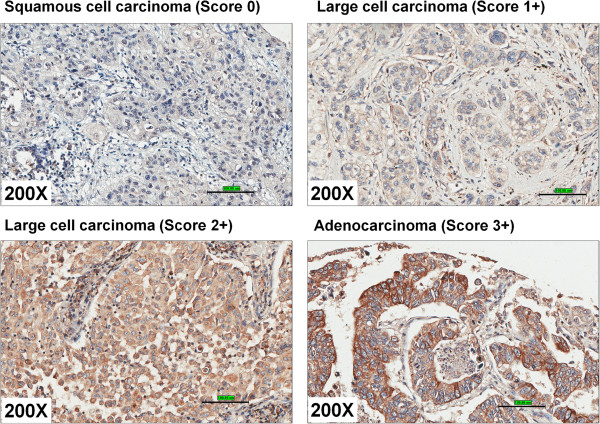
Scoring of GPER/GPR30 expression in lung tumors. The scoring pattern for GPR30 staining as follows. Score 0, negative staining for all cells; score 1+, weakly positive for cytosolic staining in <10% of cells; score 2+, moderate to strong positive staining covering between 10 to 50% of cells and score 3+, strongly positive staining including >50% cells. The images are shown at 200X magnification and the scale bar indicates 100μm. The images were collected using Aperio imagescope.